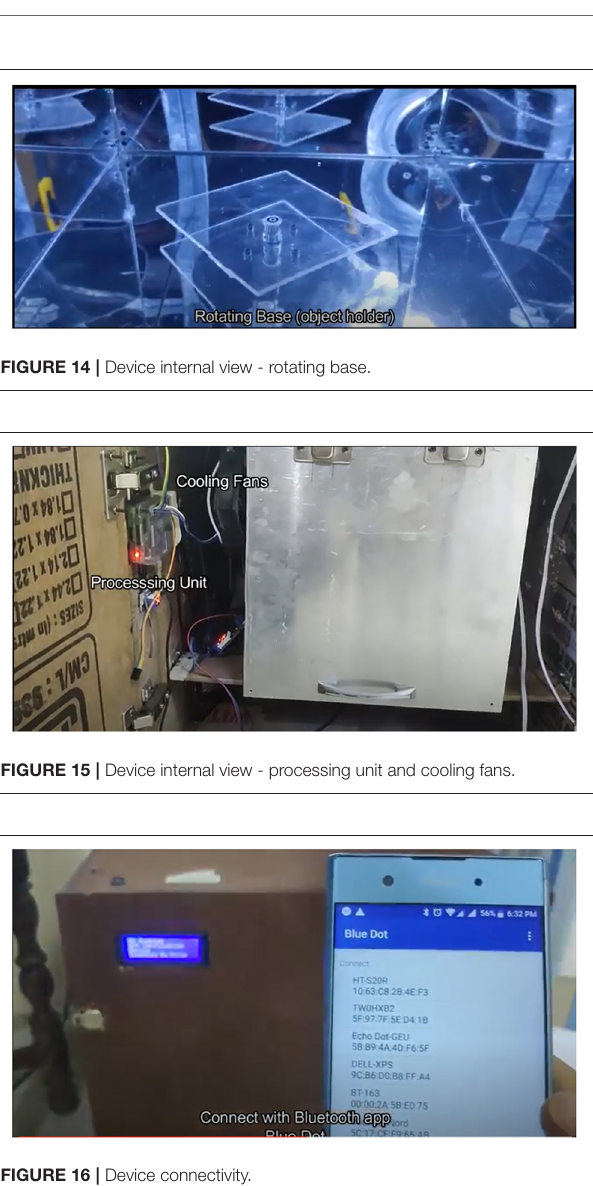
FIGURE 16 | Device